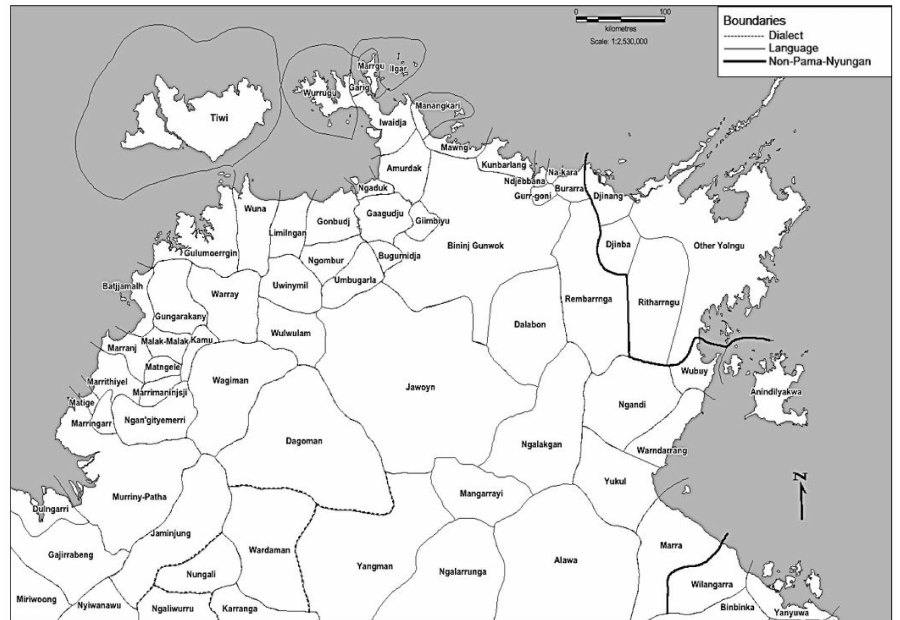
Figure 1. Anindilyakwa and surrounding Top End languages (Harvey